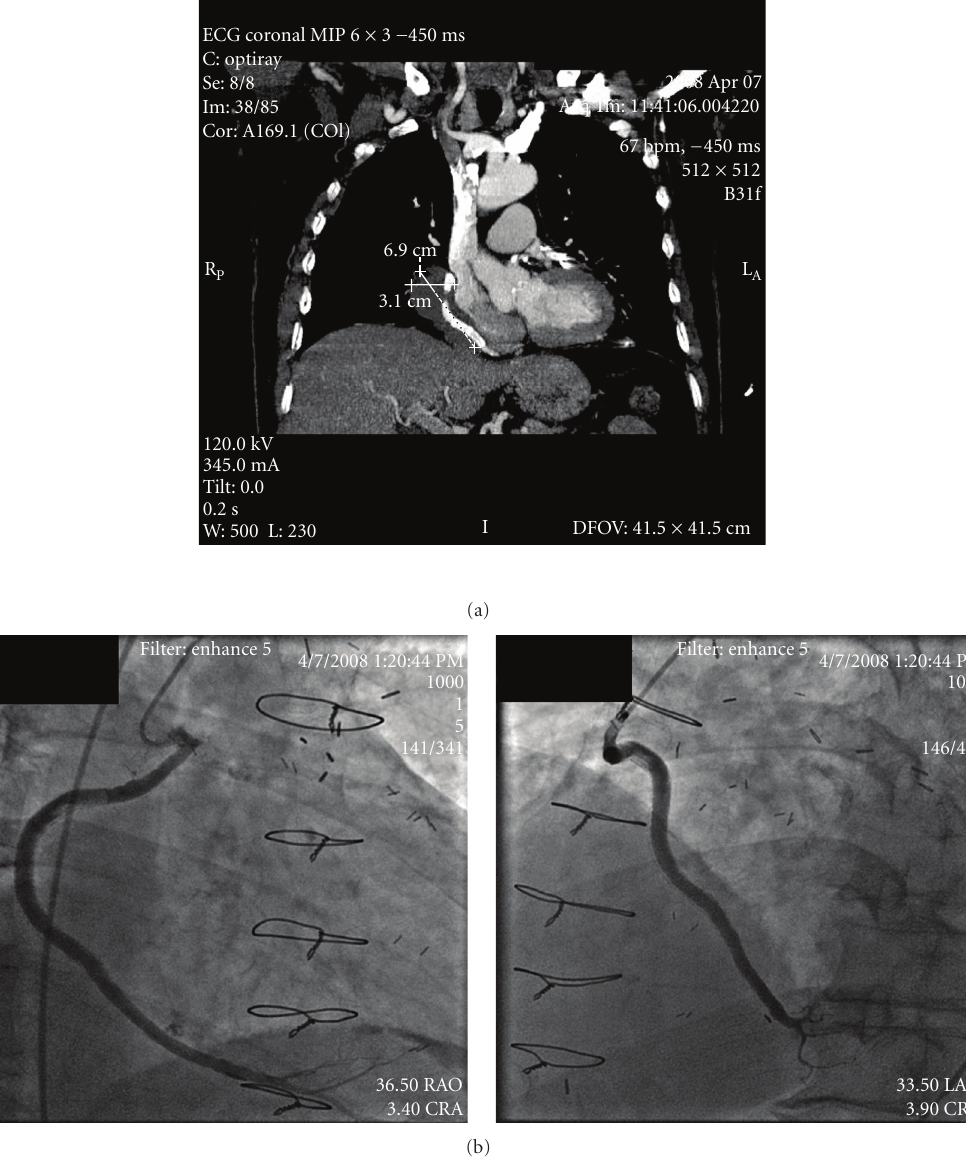
Figure 4: (a) CT of the chest in April 2008 revealing aneurysm size (3.1cm × 6.9cm) has remained unchanged. (b) Coronary angiography in April 2008 in both RAO and LAO views revealing patent stents and no evidence of leak through the covered stents into